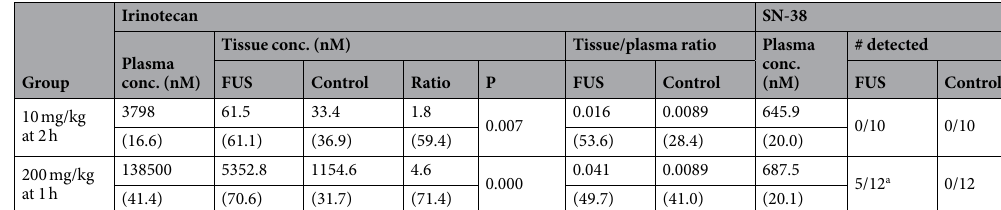
Table 4. Concentrations of irinotecan and SN-38 after BBB disruption. a Concentration: 18.0–23.9